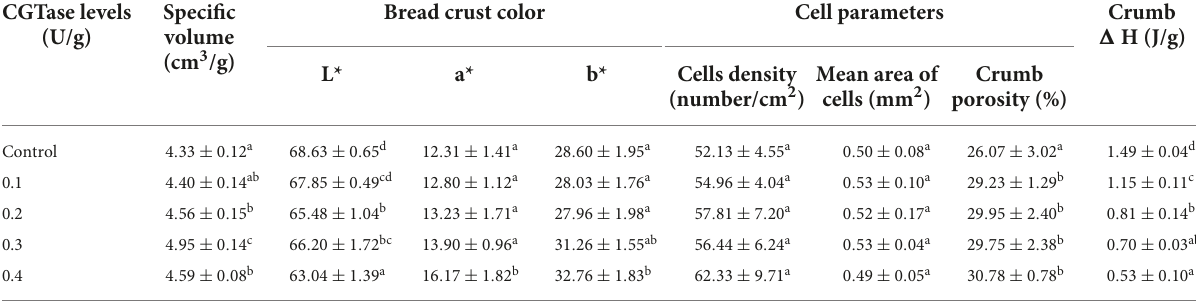
TABLE 2 Baking characteristics of bread without or with different addition amounts of